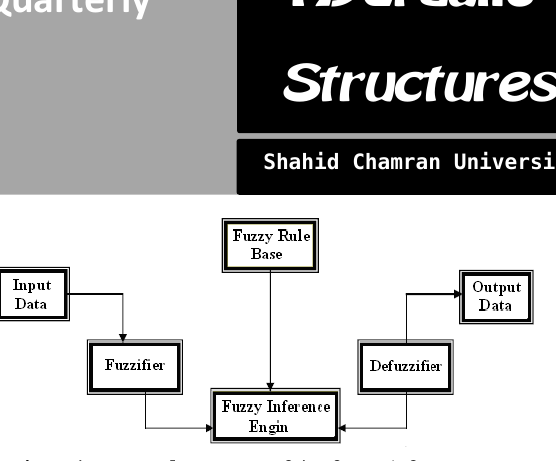
Fig.1 The general structure of the fuzzy inference system